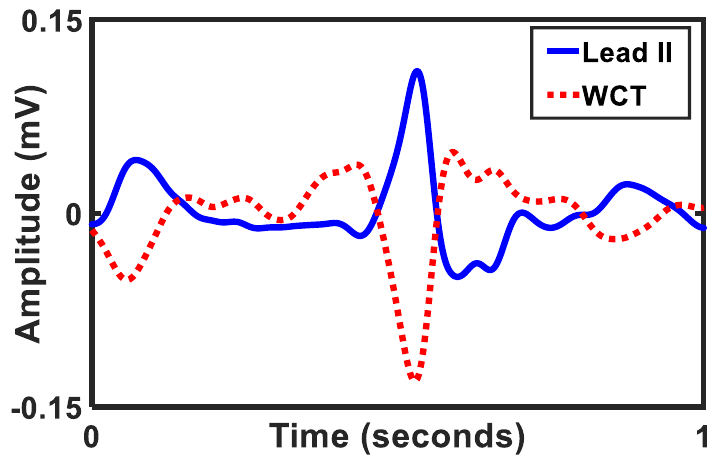
Figure 3. Example of the WCT and lead II amplitude (patient ID 32).